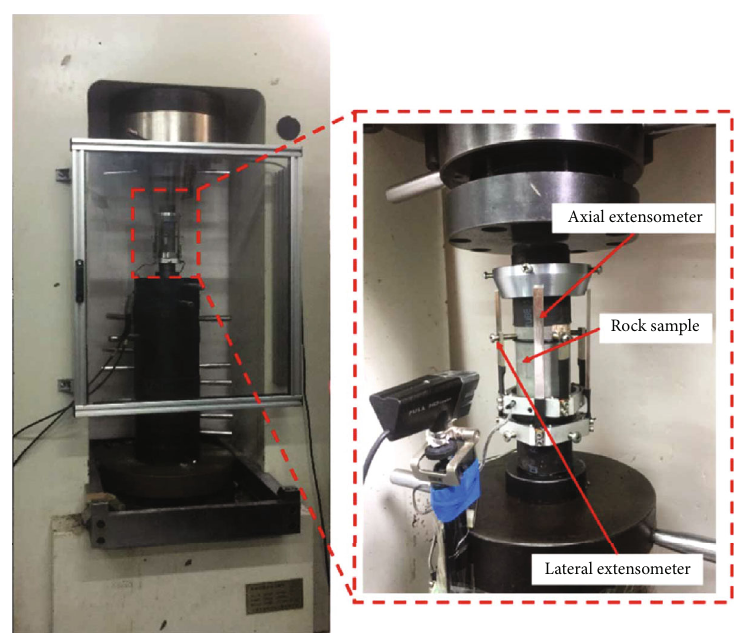
Figure 6: Rock mechanic parameter